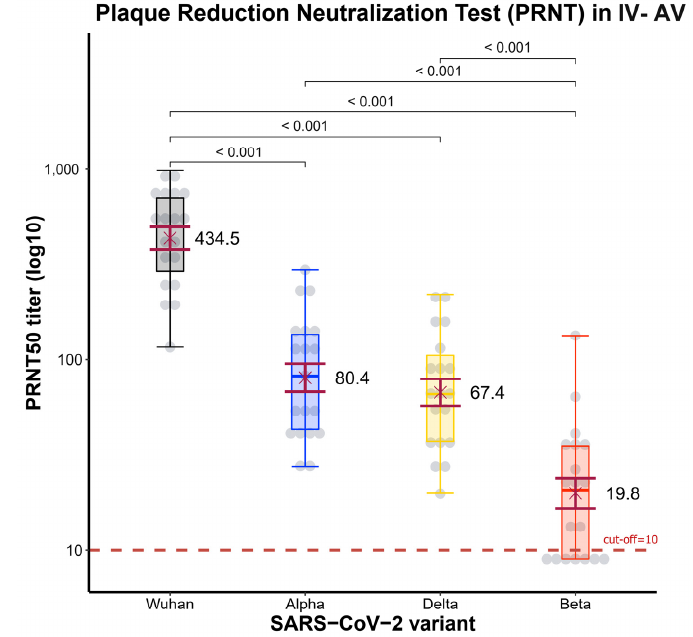
Figure 4. Boxplots of PRNT 50 level in CoronaVac-ChAdOx1 group. Boxplots indicate geometric mean PRNT 50 titer to virus variants and IQRs. Serum was collected 2 weeks after participants in the CoronaVac-ChAdOx1 group received the vaccination. The GMT of PRNT 50 was highest against the wild-type (434.5 BAU/mL, 95% CI 326–579)—significantly greater than against the Alpha variant (80.4 BAU/mL, 95% CI 56–115), Delta variant (67.4 BAU/mL, 95% CI 48–95) (all p < 0.001), and Beta variant (19.8 BAU/mL, 95% CI 14–30) ( p < 0.001). The horizontal dotted line indicates the positive detection (10 units). The Wilcoxon signed-rank test was used for assessment.